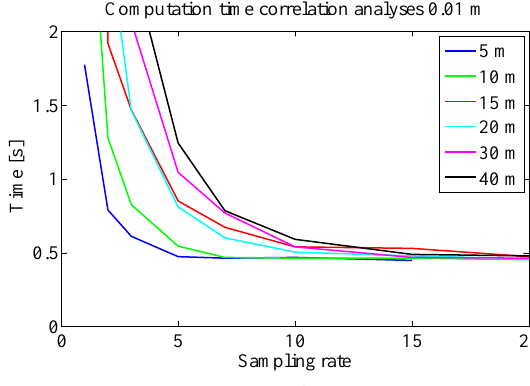
Figure 14: Accuracy (σ2D) at various sampling rates and lengths of processed scan segments.